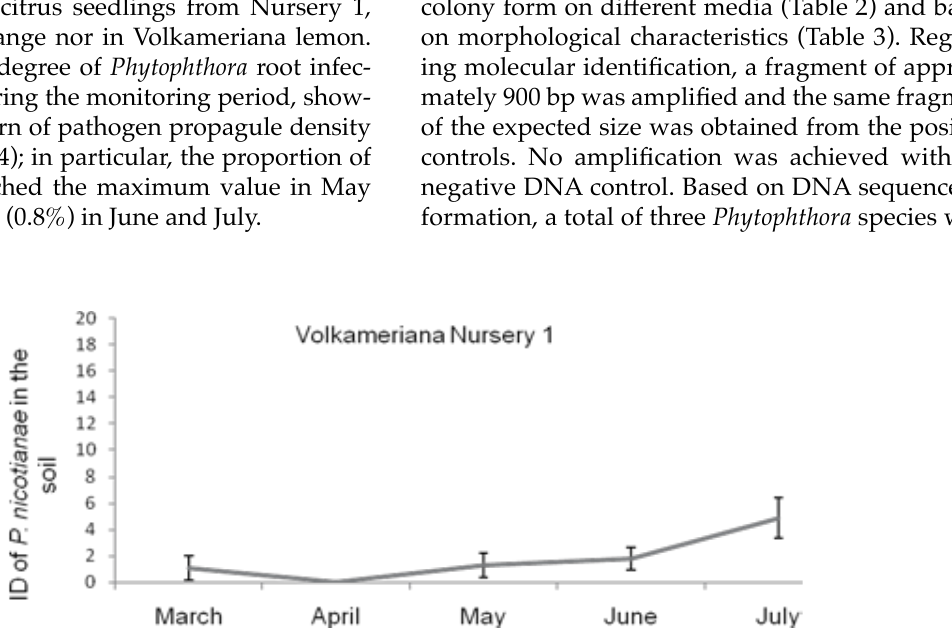
Figure 2. Seasonal variation of Phytophthora nicotianae inoculum density (ID) in Nursery 1, expressed as propagules/gram of dry soil.